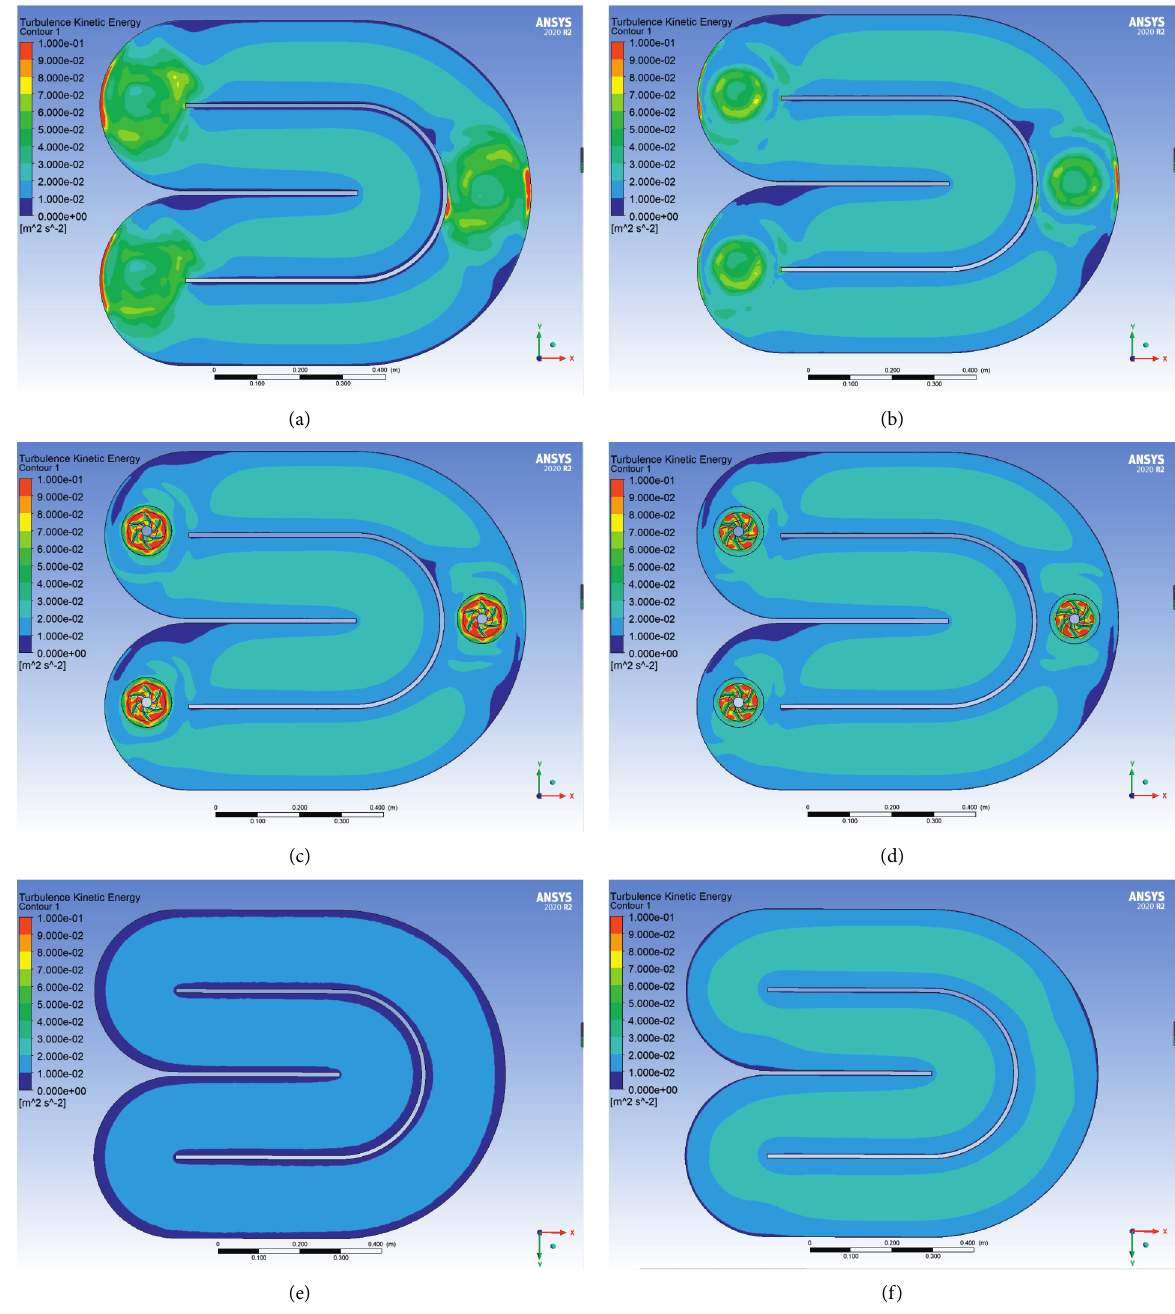
Figure 9: Turbulent kinetic energy cloud map at different depths (a) H � 330mm, (b) H � 310mm, (c) H � 290 mm, (d) H � 280mm, (e) H � 200mm, and (f) H �